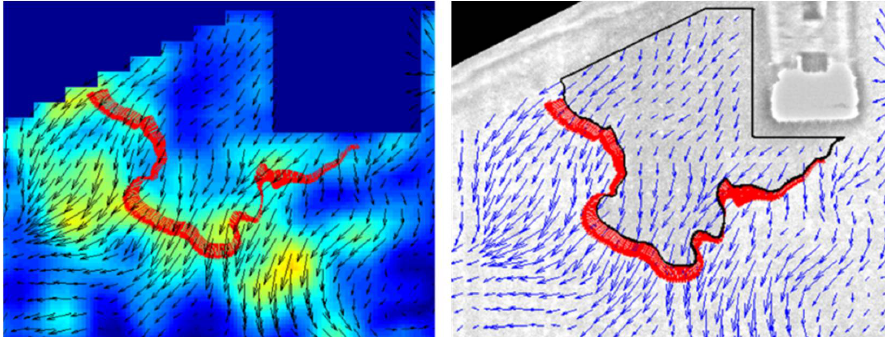
Figure 7. Vector maps show the intercept between the normal line and the second frame flame boundary.